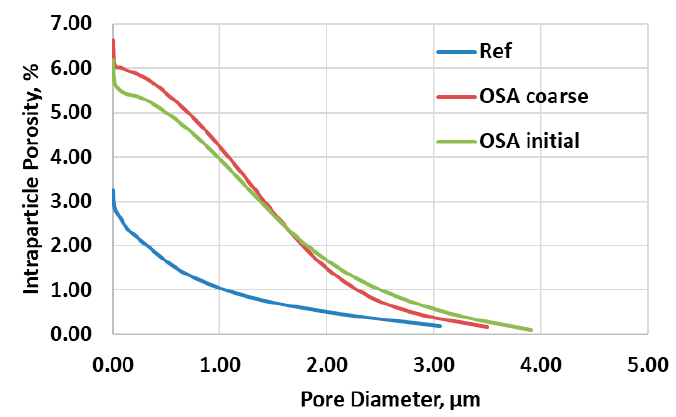
Figure 9. Intraparticle porosity as a function of pore diameter size.